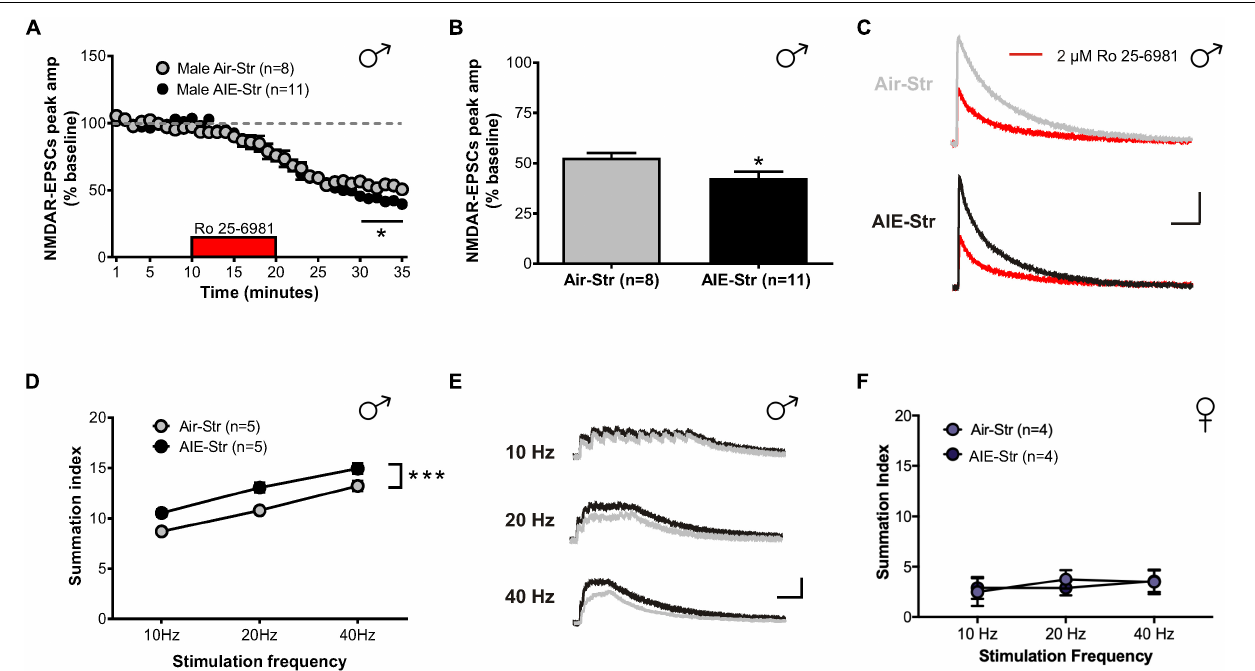
FIGURE 8 | GluN2B transmission and NMDAR plasticity in adult mice with a history of AIE following a restraint stress challenge. (A) Time course of NMDAR-EPSC peak amplitudes following a 10-min application of Ro 25–6981. (B) Quantification of the inhibition of NMDAR currents produced by Ro 25–6981, determined by calculating the percentage change in EPSC amplitude from 5 min before Ro addition to 5 min of the peak drug effect (last 5 min of washout). (C) Representative traces of NMDAR-EPSCs recorded from Air-Str (top) and AIE-Str (bottom) mice before (gray and black traces, respectively) and after (red traces) application of Ro 25–6981; vertical scale bar = 100 pA, horizontal scale bar = 200 ms. (D) Plot of the summation index across stimulation frequencies and treatments demonstrating that stress during adulthood was sufficient to restore the sensitization of NMDAR-EPSCs in adults with a history of AIE. A significant effect of treatment was determined by a two-way ANOVA, ∗∗∗ p < 0.001. (E) Representative traces (Air-Str gray, AIE-Str black) demonstrating the ability of acute stress to enhance the temporal summation of NMDAR-EPSCs in adult males with a history of AIE; vertical scale bar = 200 pA, horizontal scale bar = 200 ms. (F) Plot of the summation index across stimulation frequencies find no significant effect of stress in adult female mice with and without a history of